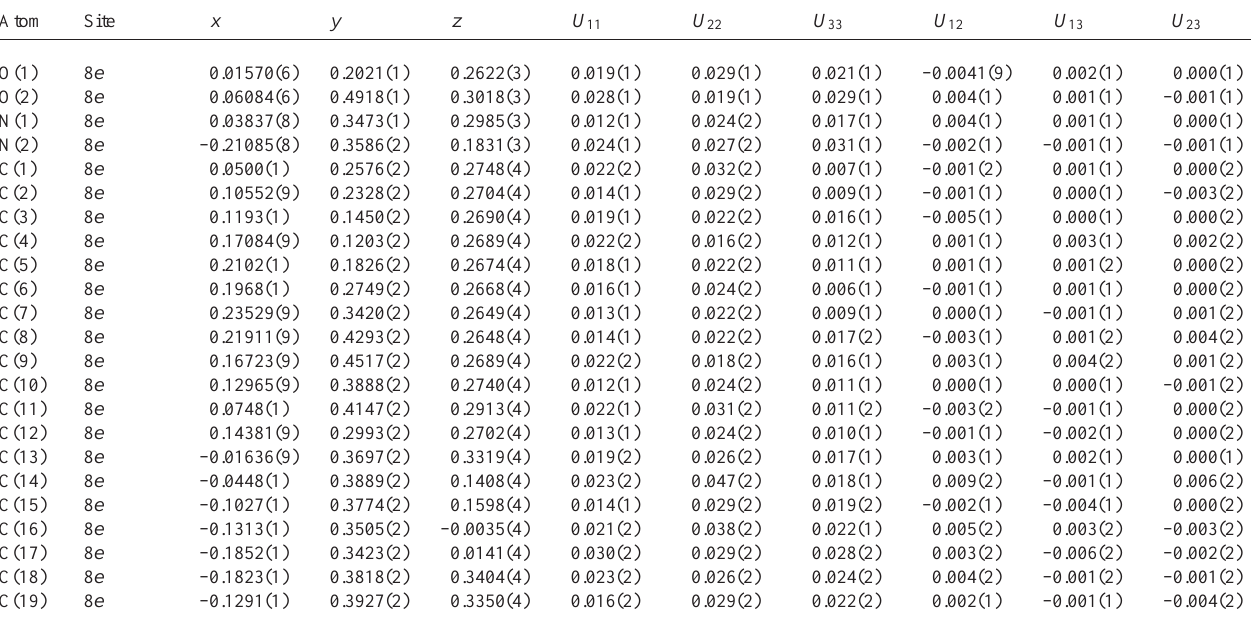
Table 3. Atomic coordinates and displacement parameters (in Å 2 )